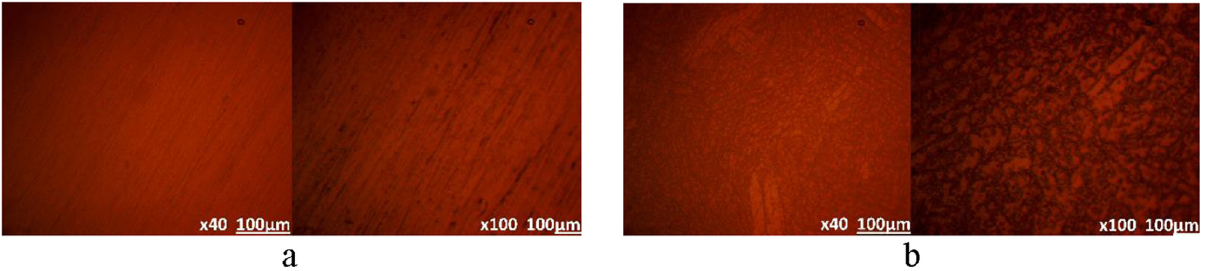
Figure 7: Optical images of B265TiA after corrosion test in ( a ) 2 M H 2 SO 4 + 10% NaCl and ( b ) 10 M H 2 SO 4 + 10% NaCl at 30°C.